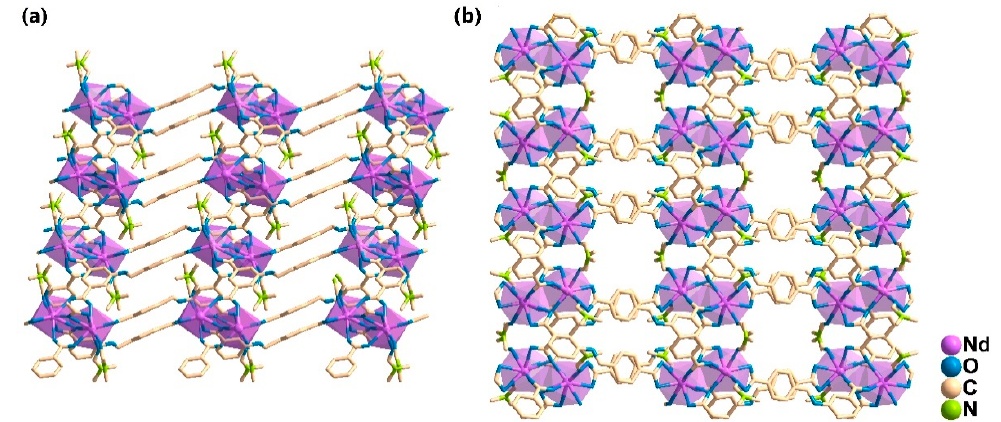
Figure 2. ( a ) The structure of 1 with channels along the b axe; and ( b ) the structure of 1 with channels along the c axe.